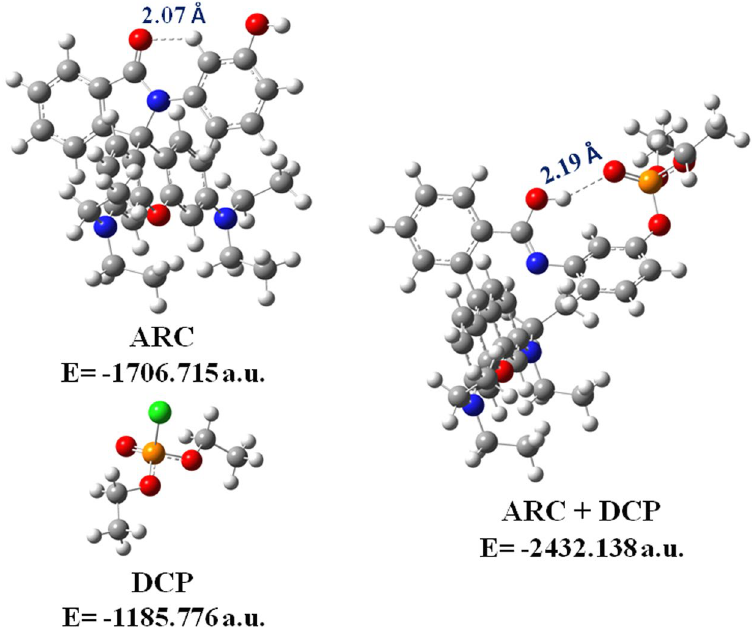
Figure 3. Optimized structures of ARC , DCP and ARC-DCP complex with their corresponding energies. The hydrogen bond interactions are denoted by dotted